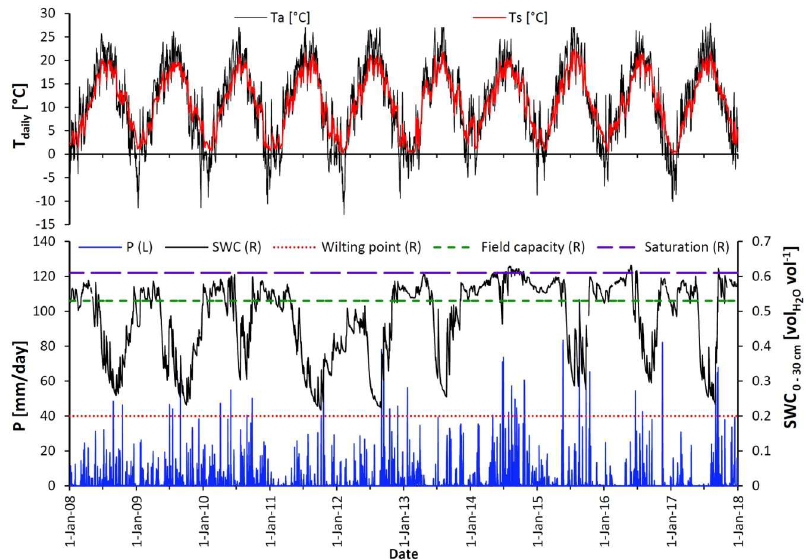
Figure 3. Top panel: Average daily air ( Ta ) and soil ( Ts ) temperatures; bottom panel: daily precipitation (P, left y-axis) and soil water content ( SWC , right y-axis) in the top 30 cm soil layer. Horizontal lines indicate the values of SWC at wilting point (dotted line), at field capacity (short-dashed line) and at saturation point (long-dashed line) for the location of the EC site [37].